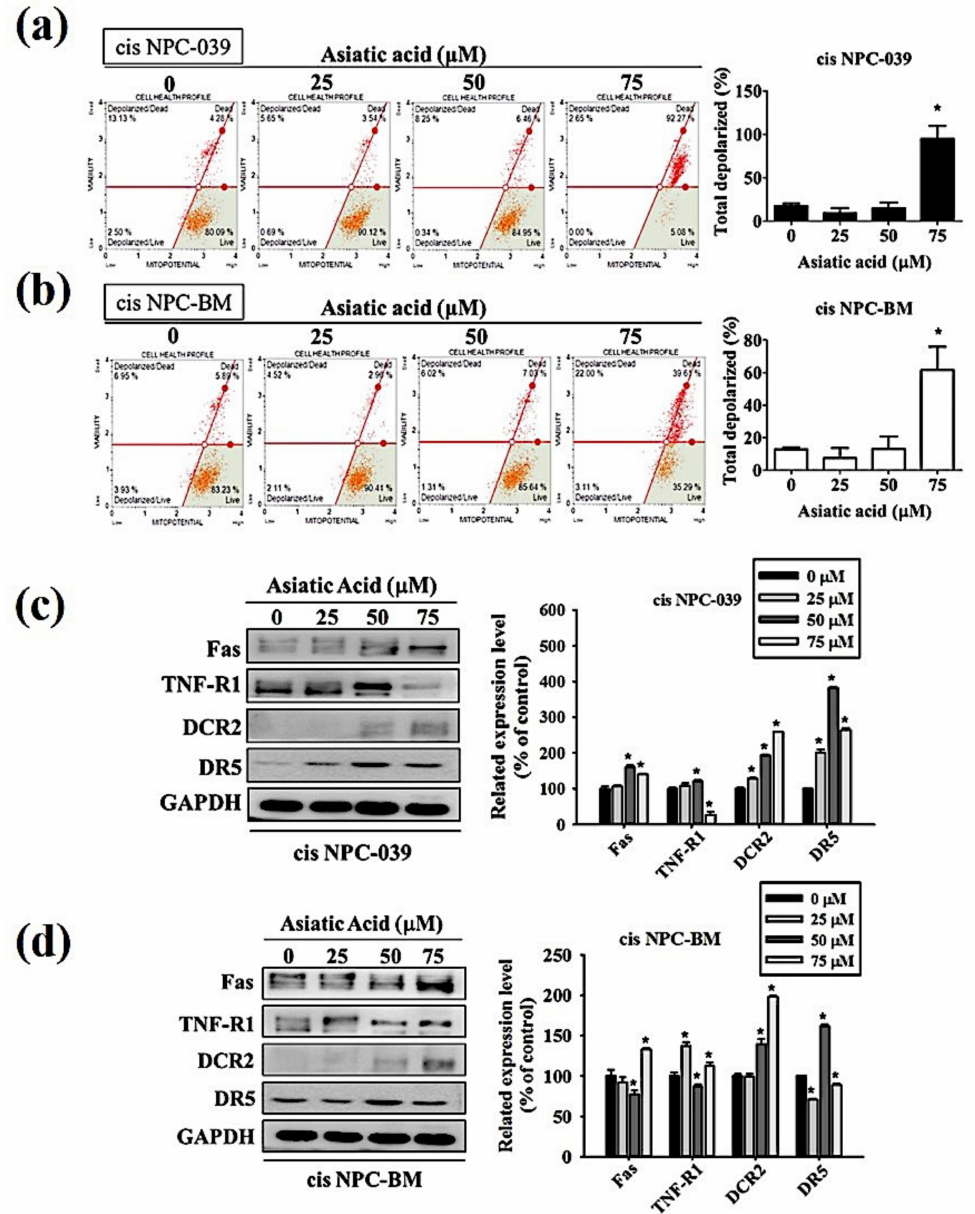
Figure 4. Asiatic acid cause cis NPC-039 and cis NPC-BM cell apoptosis thought the intrinsic pathway and the extrinsic pathway. ( a ) E ff ect of Asiatic acid on mitochondrial membrane potential was analyzed by flow cytometric ( b ) The related mitochondrial membrane depolarized levels compared with control. ( c ) The expression levels of Fas, TNF-R1, DcR2, and DR5 were detected by Western blot. ( d ) The relative band density was normalized to GAPDH as a densitometer. * p < 0.05 versus control